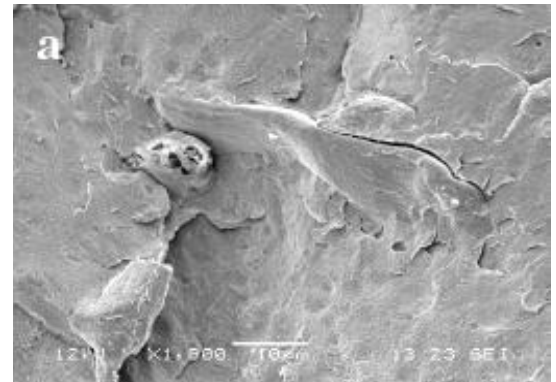
Figure 8. SEM micrographs of (a) PS/Cell and (b) PS/Oat